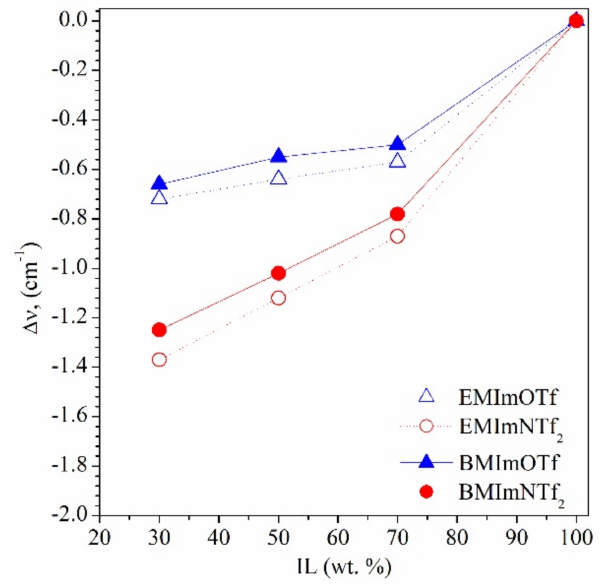
Figure 5. Shifts of the IR absorption band of C 2 -H bond (imidazolium ring of ionic liquid) as a function of IL concentration in ionogels. Lines are guides for